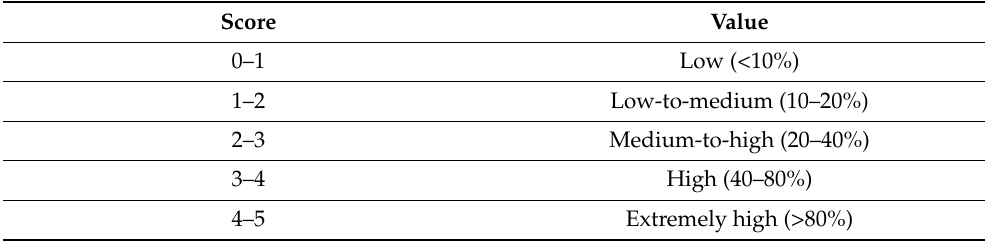
Figure 3. Comparison of water stress in Madagascar and Japan. Source: Aqueduct 3.0 Country and Province Rankings. Table 2. Water stress score